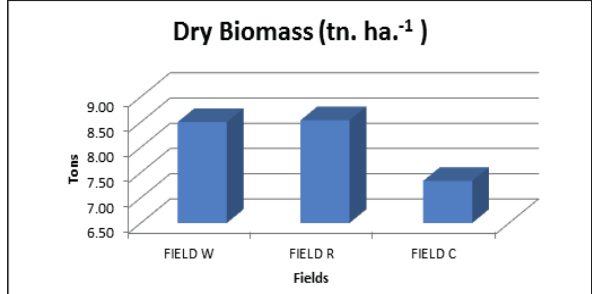
Figure 5. Eight month year old dry biomass in the three farms in Santo Tomas, Yurimaguas (W, R and C are Washington, Roberto and Clais farmers, respectively).